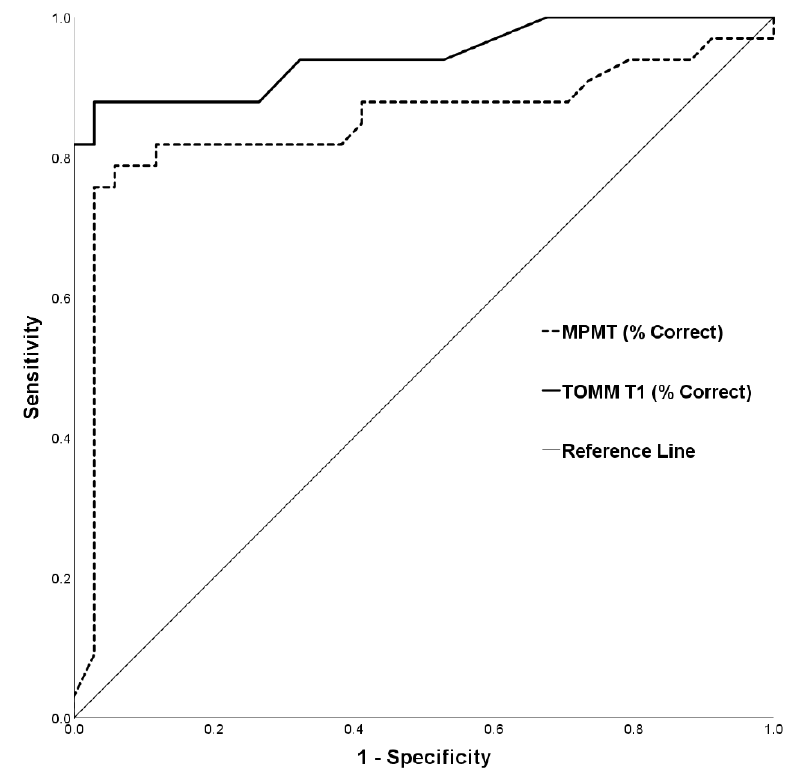
Figure 3. ROC curves for differentiating simulators and honest controls using the MPMT (AUC = 0.85) and TOMM T1 (AUC = 0.94). Note: AUC = Area under the curve; ROC = receiver operating characteristic; TOMM T1= Test of Memory Malingering trial 1. Table 2. Classification accuracy based on utility estimates (specificity/sensitivity/PPP/NPP values) of the MPMT ’s primary outcome measure (% correct responses).